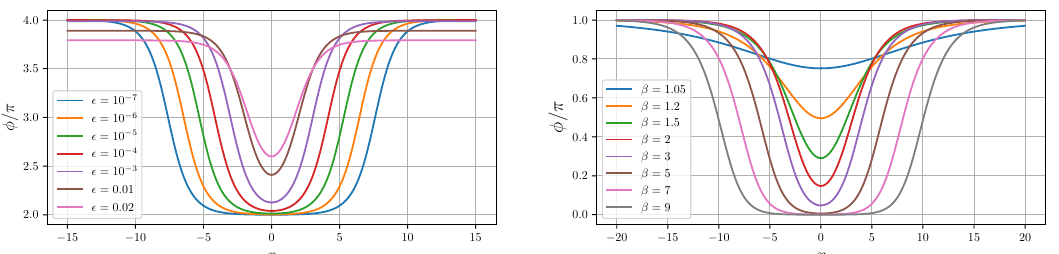
Figure 6 . Profiles of unstable lumps. Left: unstable lumps for small values of (cid:15) based on the first false vacuum ψ > 2 π ; right: unstable lumps for (cid:15) → (cid:15) cr based on the false vacuum at ψ = π and parametrised by β , with (cid:15) = (cid:15) cr tanh( β )